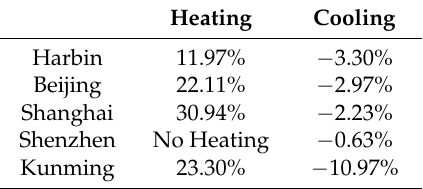
Table 15. Heating and cooling energy saving ratio comparisons between RC and CLT